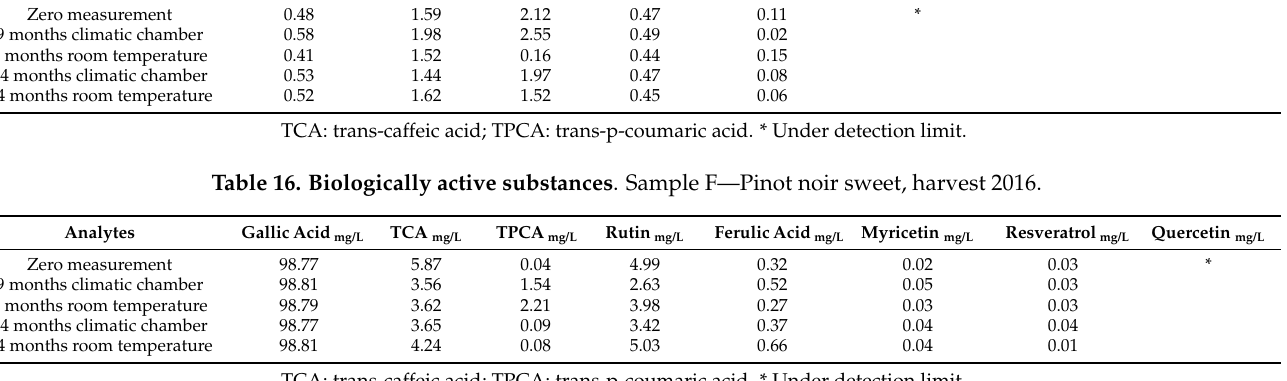
Table 15. Biologically active substances. Sample D—Cabernet Sauvignon ros é , harvest 2016. Analytes GallicAcid mg/L Zero measurement